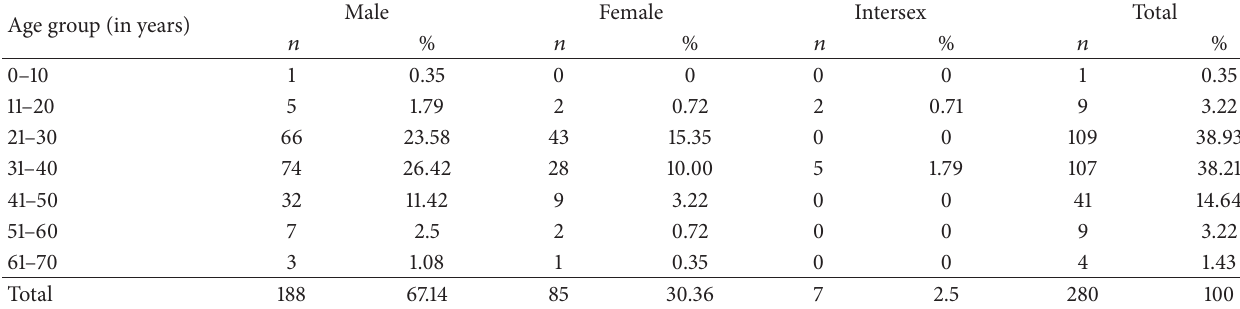
Table 1: Age and sex distribution of the patients ( 𝑛 = 280 ).